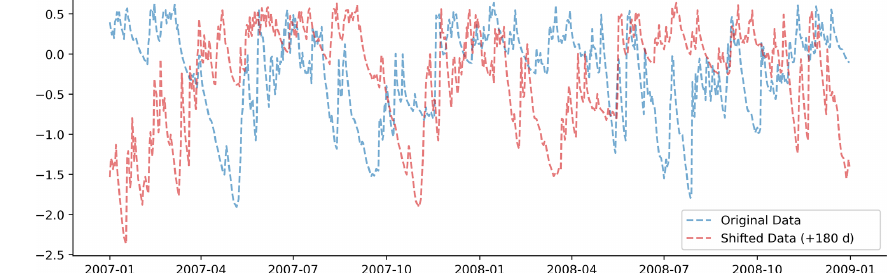
Figure A2. Shifting the input data by 180d in time breaks the temporal link between the inputs (shown here) and the target variables (not shown). We fit the probe on the shifted data to determine how much less information it contains when compared with the original